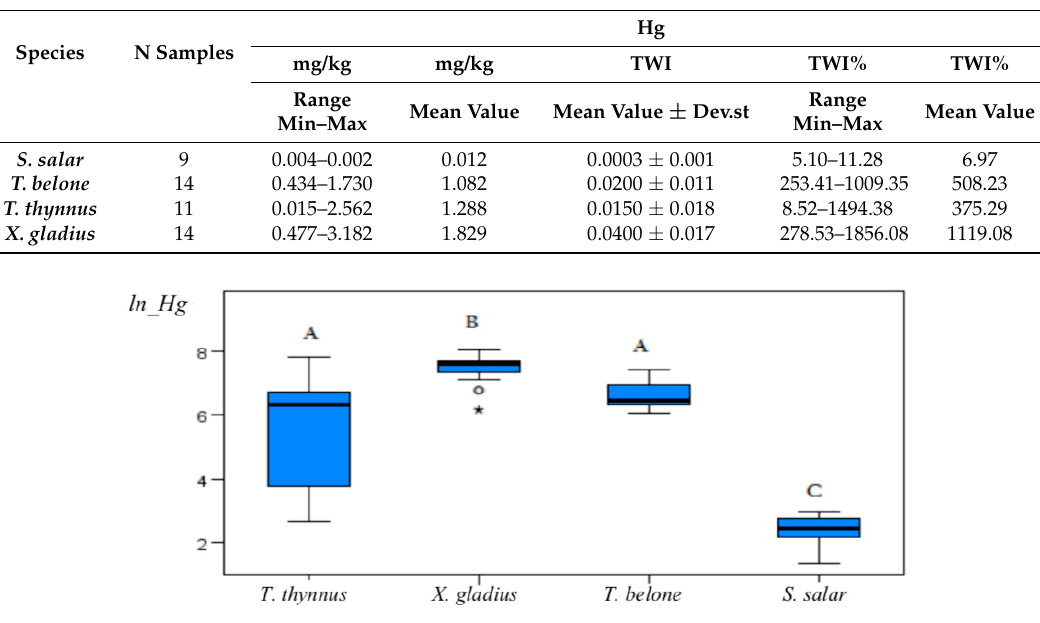
Figure 1. Kruskall-Wallis test for analyzed samples.